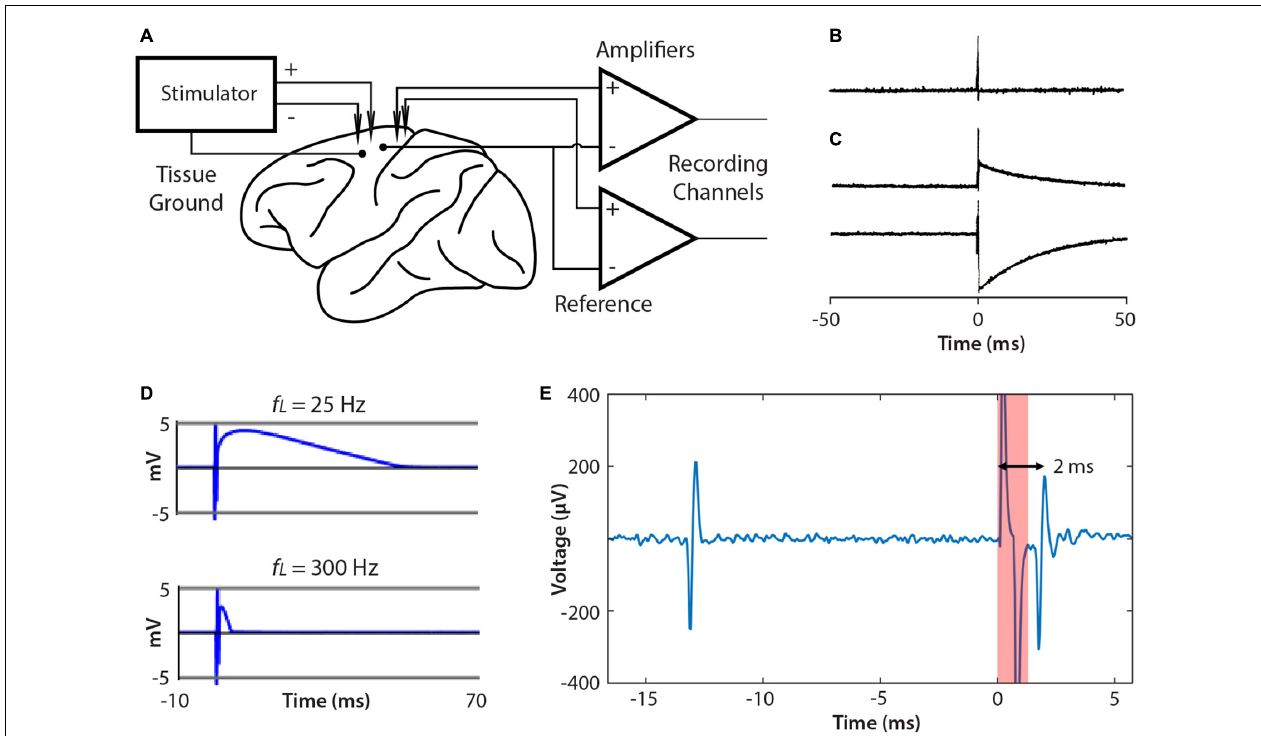
FIGURE 6 | Connections to brain and artifacts. (A) Single ended recording uses the same reference site for each channel. The NC3 stimulator employs a tissue ground and supports differential stimulation, which can reduce artifacts. (B) Stimulus artifacts that do not exceed the amplifier input range are very brief ( < 2 ms). (C) Examples of stimulus artifacts that may occur when stimulation saturates the input amplifier. (D) Artifacts are affected by the input filter’s low pass cut-off ( fL ). Increasing fL from 25 to 300 Hz shortens the artifact duration. (E) Example of a spontaneous spike (left) followed by a stimulus-evoked spike